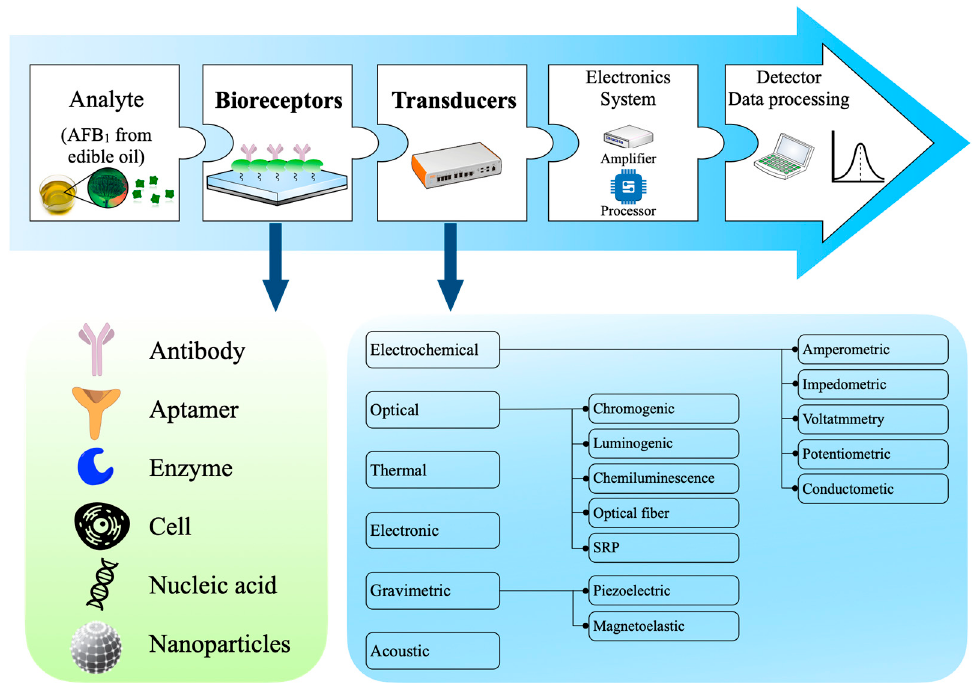
Figure 6. Schematic diagram of typical biosensor. Including analyzer, bioreceptor, transducer, electronic system (amplifier and processor), detector (for data processing). electronic system (amplifier and processor), detector (for data